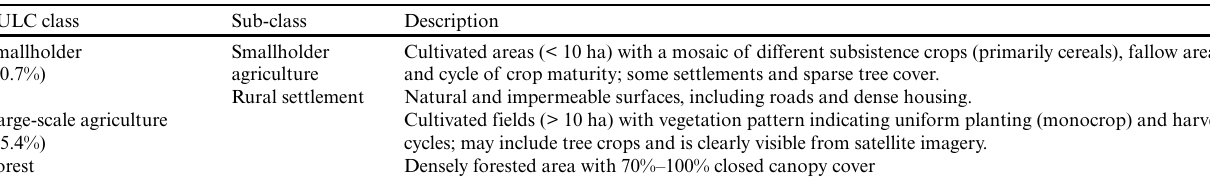
Table 1 . Land use and land cover classes. Values in parentheses under the aggregated classes represent the inter-rater reliability. LULC